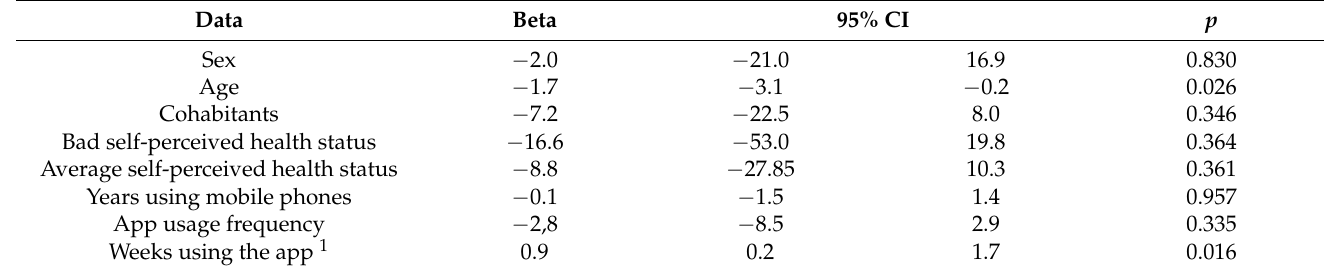
Table 3. Stepwise linear regression between fulfillment of steps walked and demographic